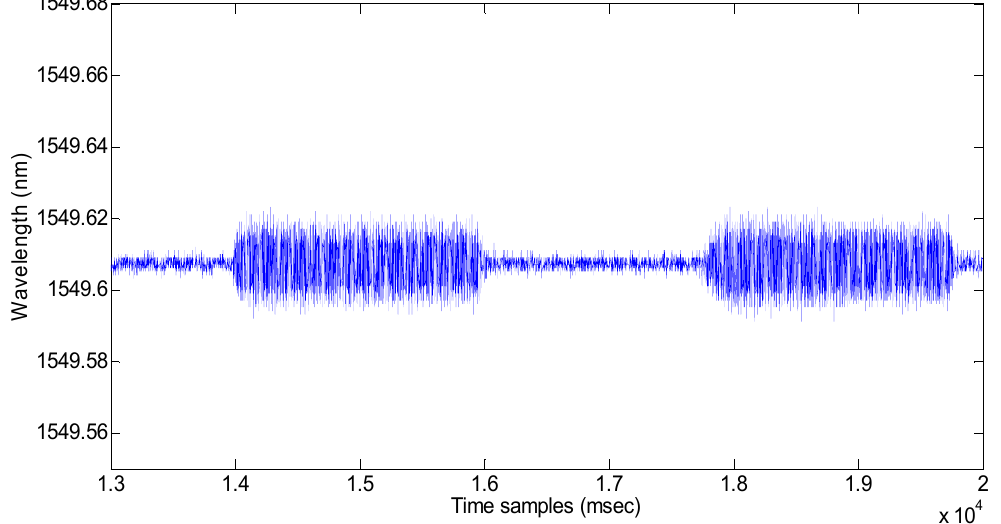
Figure 8. Time varying data of central wavelength position of FBG where the phone vibration is dominant. There was no oscillation and the sensing beam appeared to be static. The configuration is the same as shown in Figure 2 schematic.